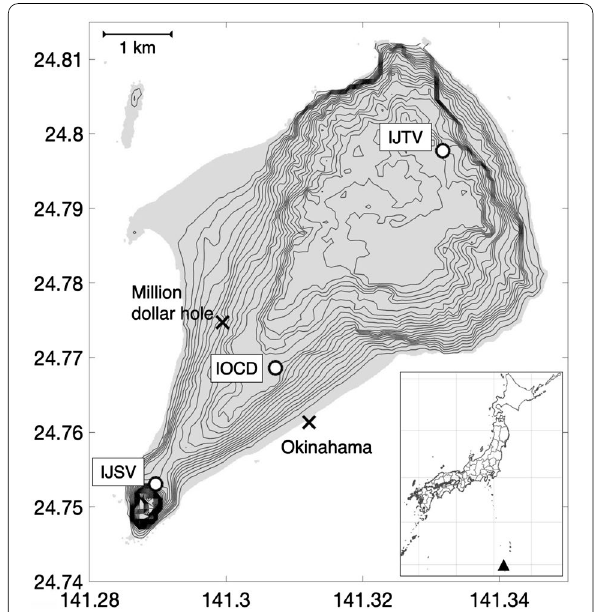
Fig. 1 Map of Ioto Island with the station locations shown by open circles. The triangle in the inset marks the location of Ioto Island in Japan. IOCD has a seismometer and a microphone, of which data are mainly used in this study. IJSV and IJTV are seismic stations. The 2013 eruption and water spouts accompanied by the 2018 activity occurred at Million dollar hole and in shallow water near Okinahama coast marked with crosses, respectively (Japan Meteorological Agency 2013,